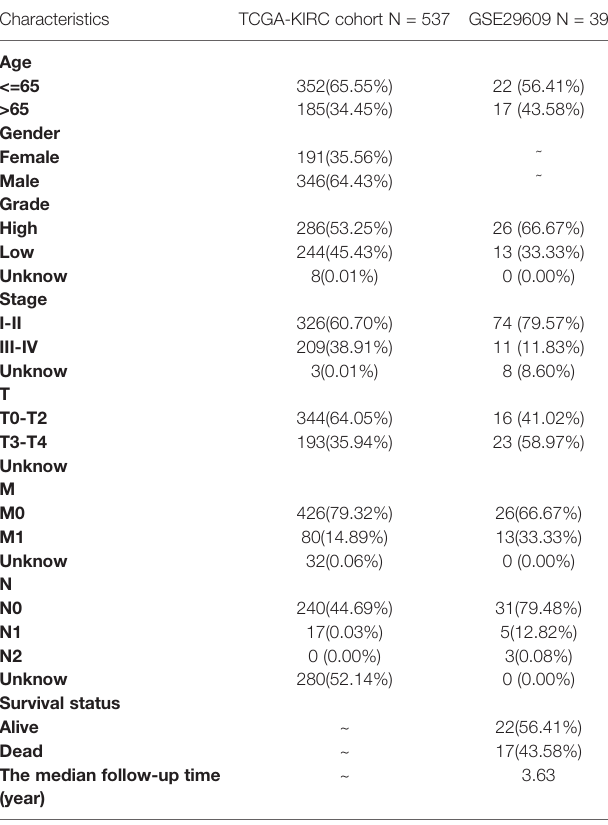
TABLE 1 | Clinicopathological characteristics of KIRC patients from the TCGA and GEO databases.